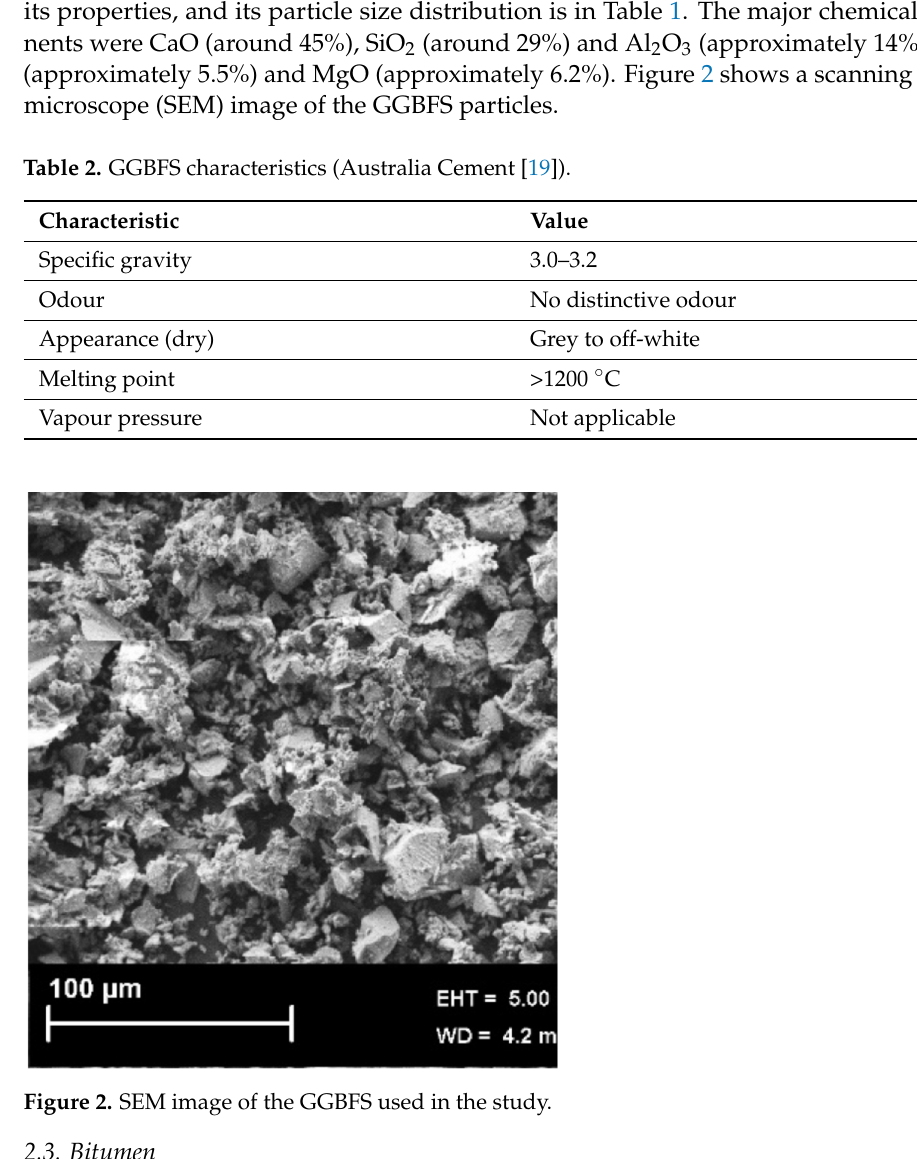
Table 1. PSD of the materials.